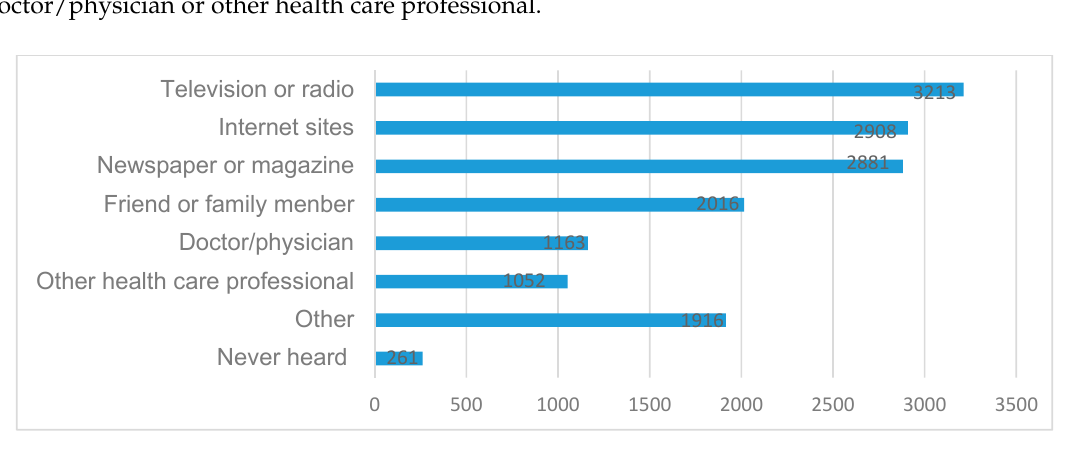
Figure 2. Where the respondents get health-related knowledge on urban air pollution.